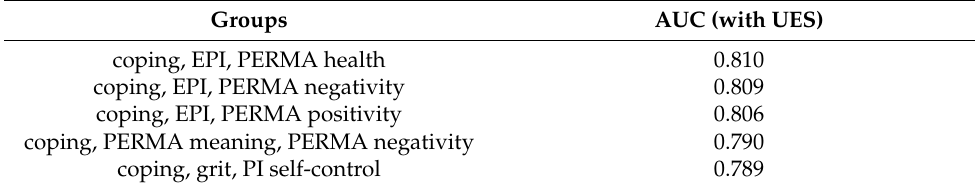
Table 4. The predictive power of the five best